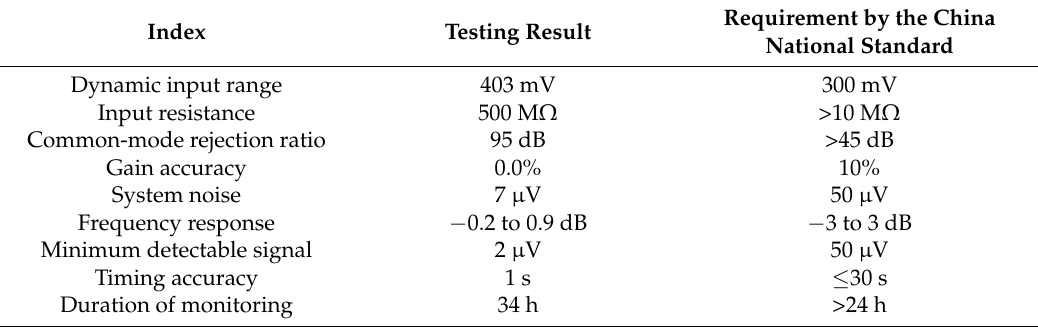
Table 3. Fetal ECG collector performance testing